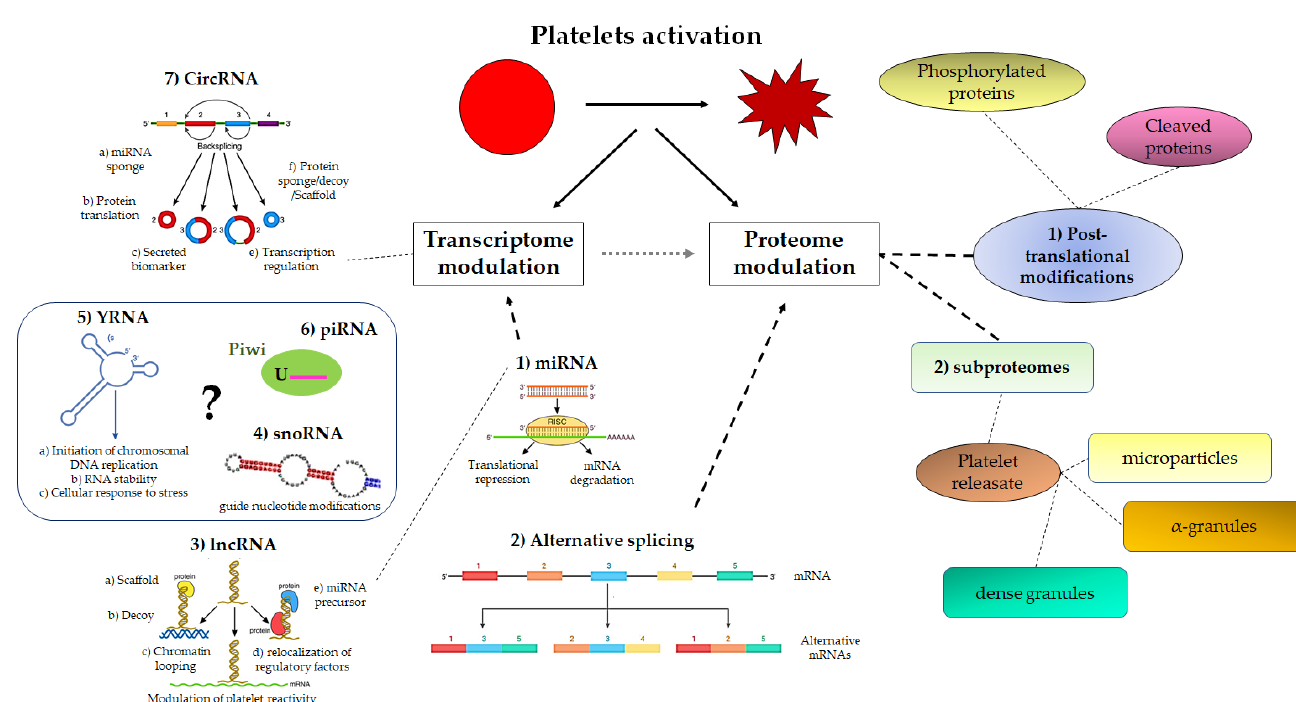
Figure 3. Schematic view of platelet transcriptome/proteome modulation upon activation. This dia- gram illustrates the complex interplay between platelets’ transcriptome and proteome via miRNAs and mRNA alternative splicing. It is also reported that noncoding RNAs might affect the transcrip- tome (see text for details). Finally, post-translational modifications may occur once platelet